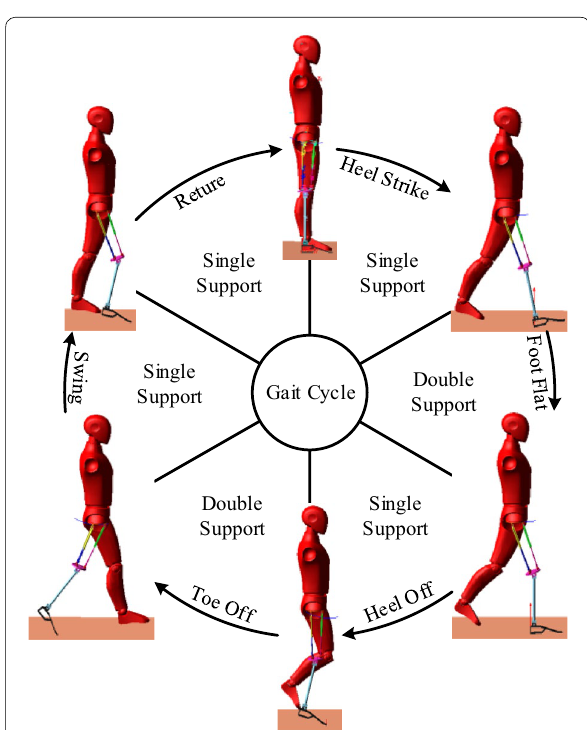
Figure 16 The movements of the prosthetic mechanism in a gait cycle